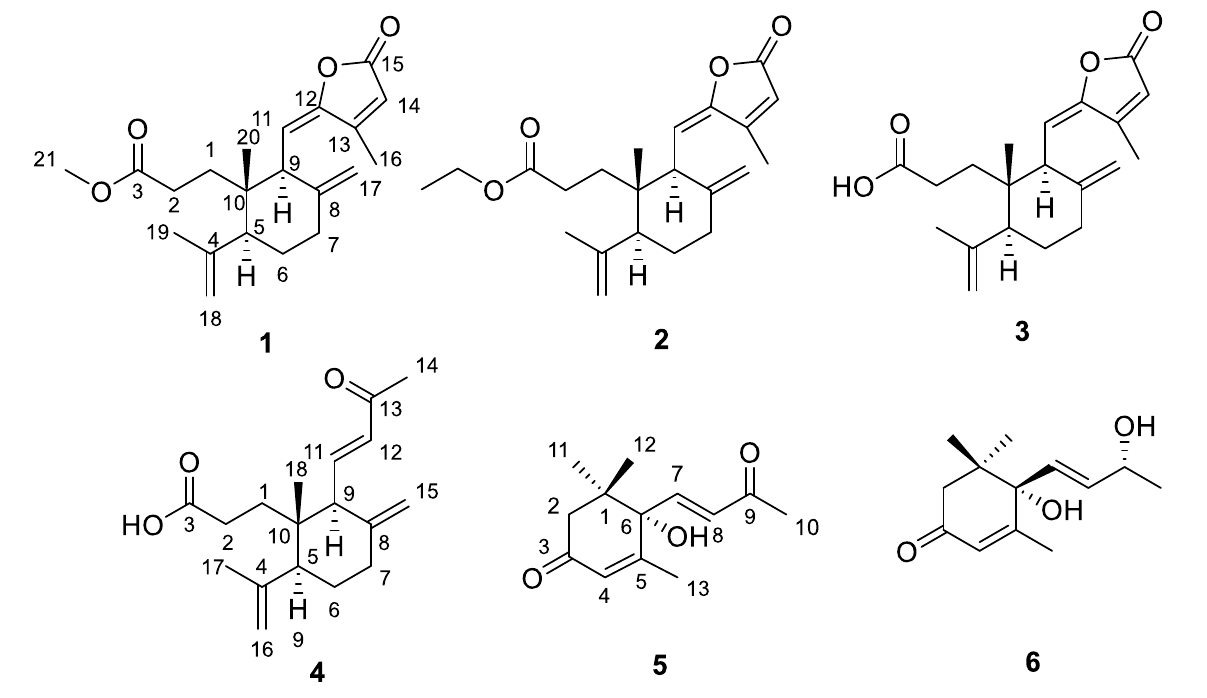
Figure 1. Structures of compounds 1 – 6 isolated from Callicarpa nudiflora .